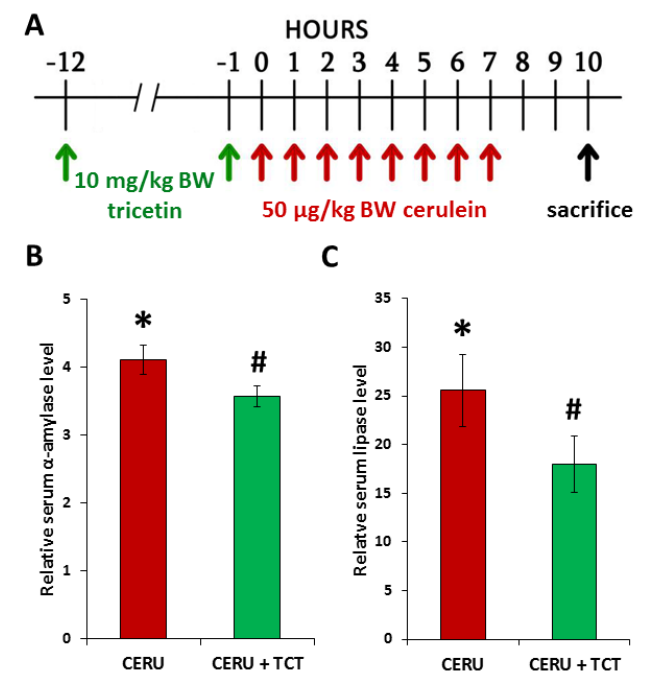
Figure 4. Tricetin inhibits tissue injury in acute pancreatitis. Acute pancreatitis was induced in mice with intraperitoneal injections (8 × 50 μ g/kg BW) of cerulein at hourly intervals. The animals were sacrificed 10 h after the first cerulein injection. Tricetin (TCT) was applied as a pretreatment (2 × 10 mg/kg BW) in i.p. injections, 12 h and 1 h before the first cerulein injection ( A ). Serum levels of amylase and lipase were measured. Error bars represent SD of six mice. Statistical analysis was performed with one-way ANOVA test followed by Tukey’s post hoc test. The cerulein treatment caused significantly (* p < 0.05) elevated serum alpha amylase ( B ) and lipase ( C ) levels, which were significantly (# p < 0.05) reduced by TCT pretreatment ( B , C ).